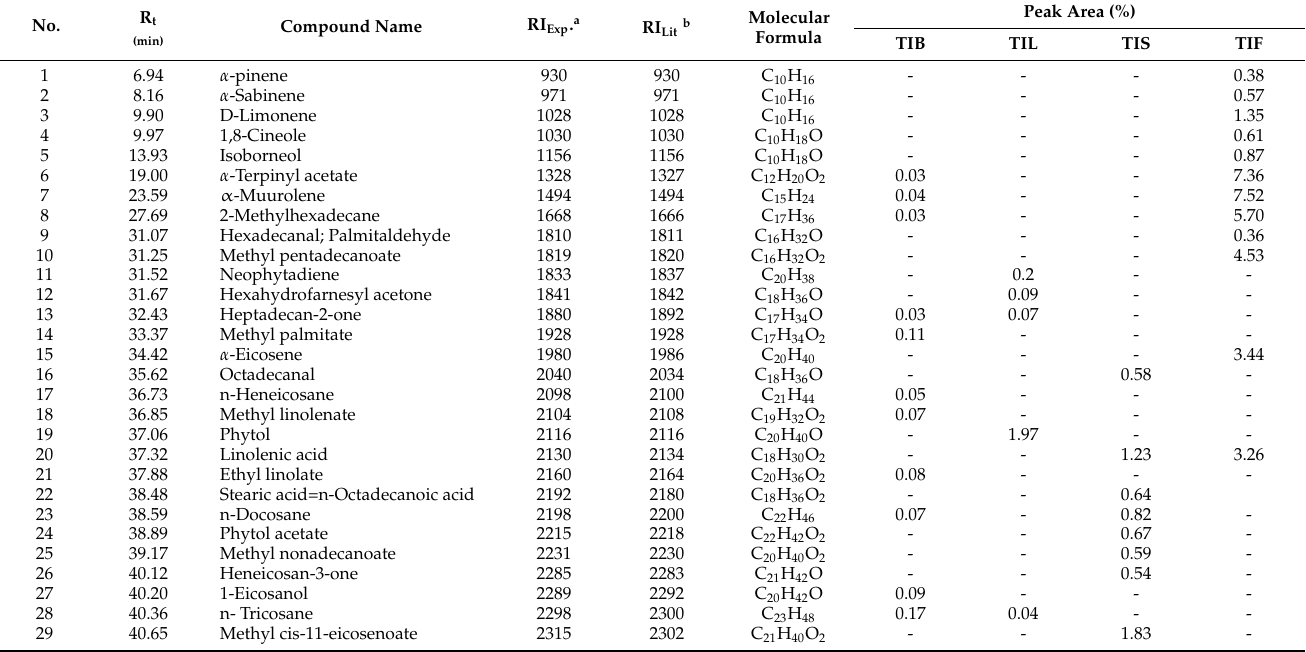
Table 1. Chemical profile of n -hexane extract from various organs of T. indica : TIB (bark), TIL (leaves), TIS (seeds), and TIF (fruits) using GC/MS